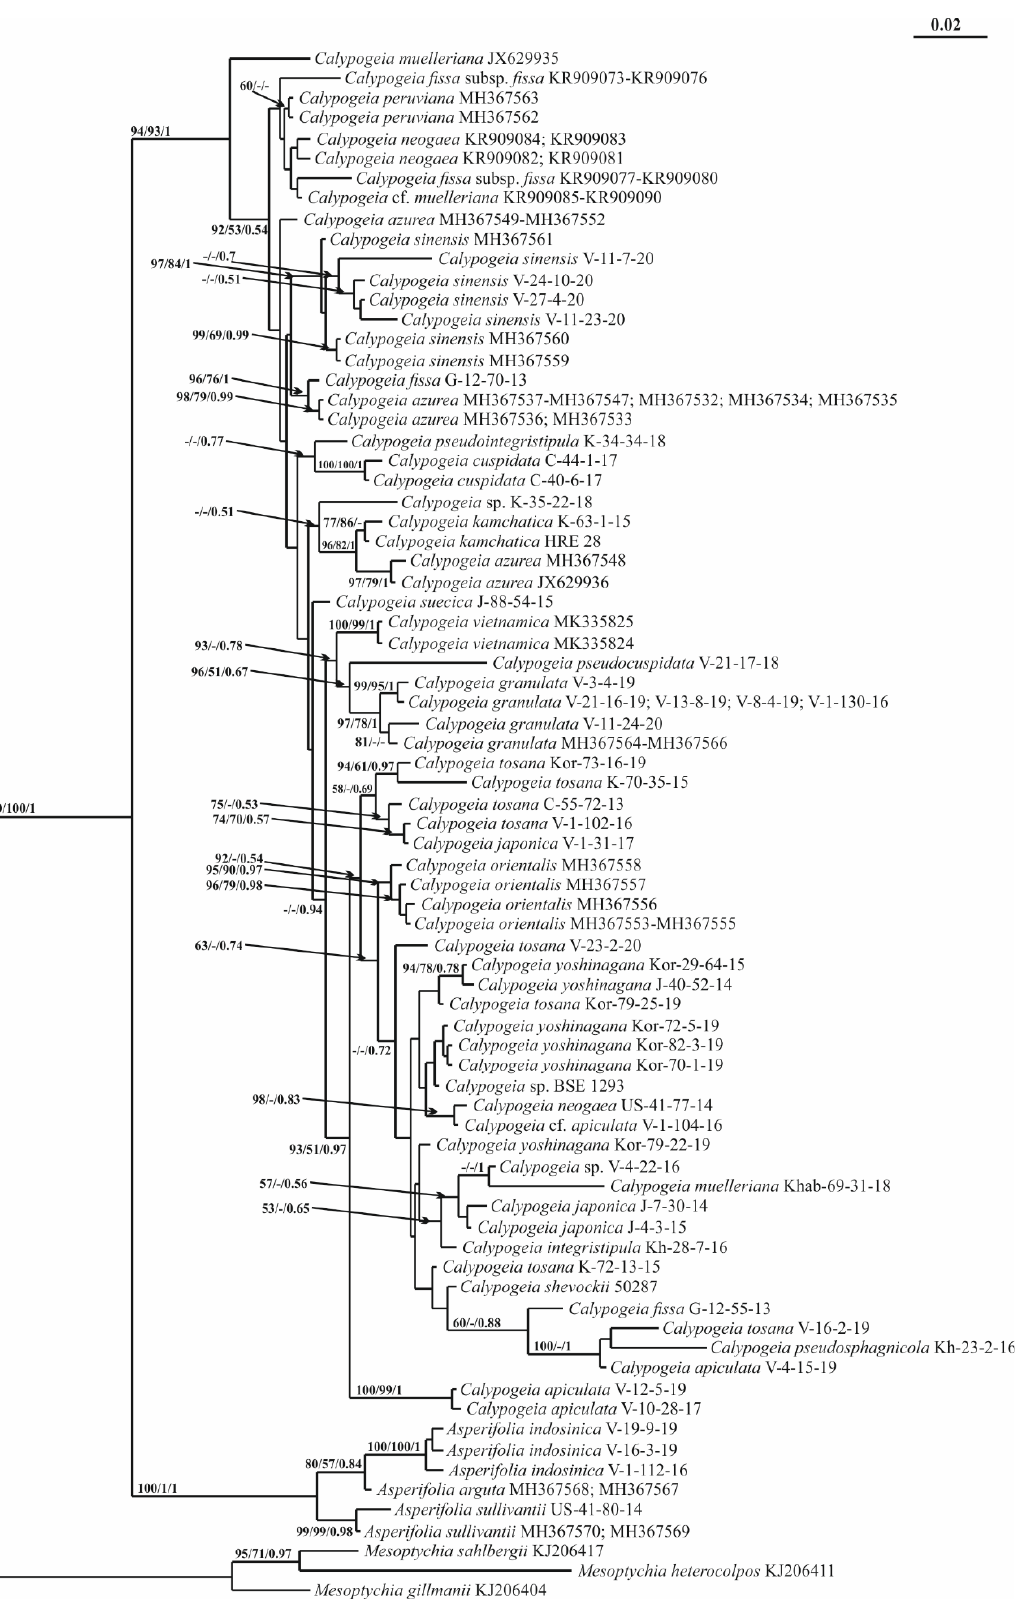
Figure 5. Phylogram obtained in a Bayesian analysis for the genus Calypogeia and related taxa based on ITS2. Bootstrap support values > 50% in MP and ML analyses and Bayesian posterior probabilities > 0.50 are indicated. Scale bar denotes number of nucleotide substitutions per site.